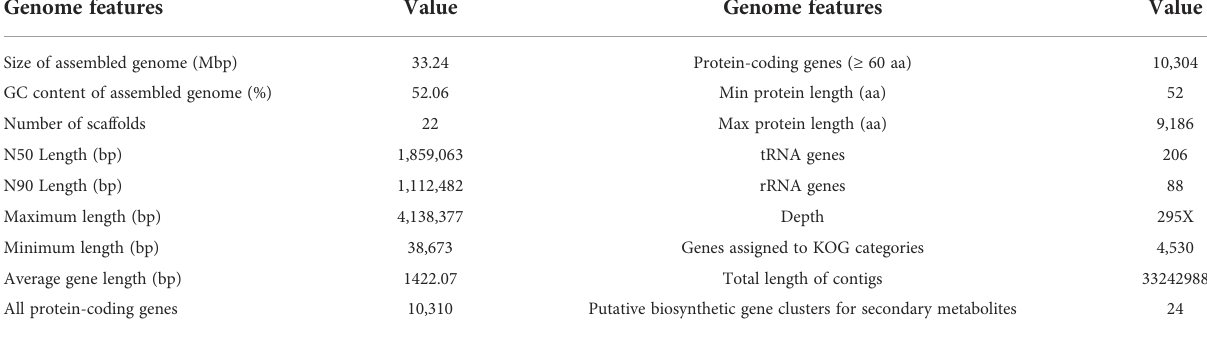
TABLE 2 Genome features of Epicoccum latusicollum HGUP191049.